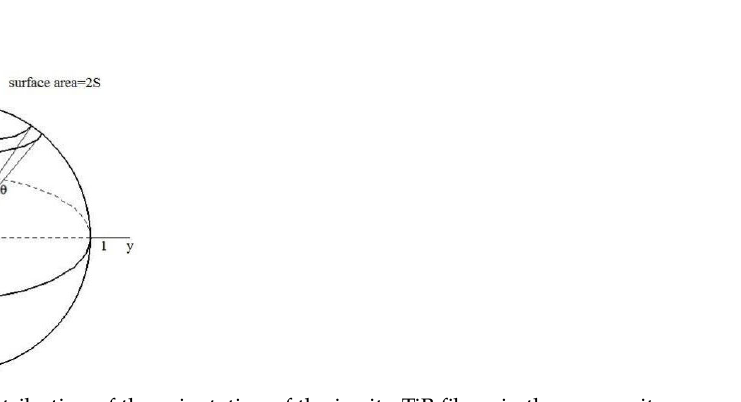
Figure 5. Initial distribution of the orientation of the in situ TiB fibers in the composite.